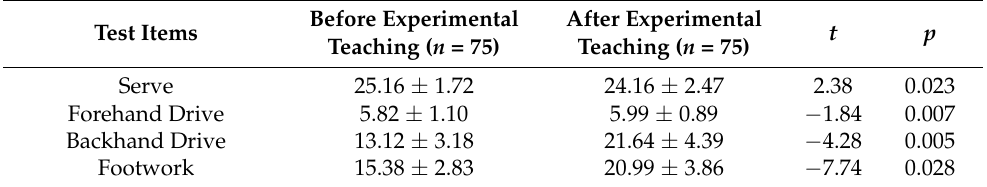
Table 11. Comparison of EG’s Tennis Learning Performance before and after Experimental Teaching.